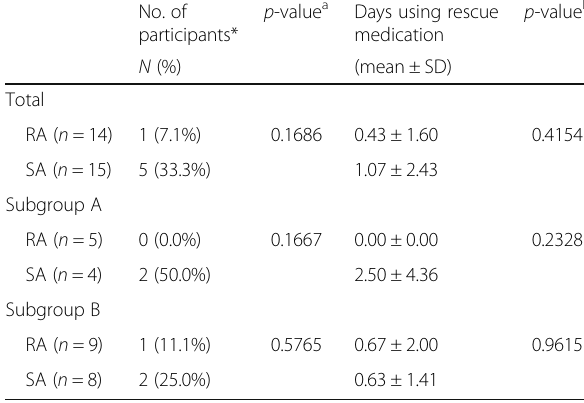
Table 3 Rescue medication use during overall study